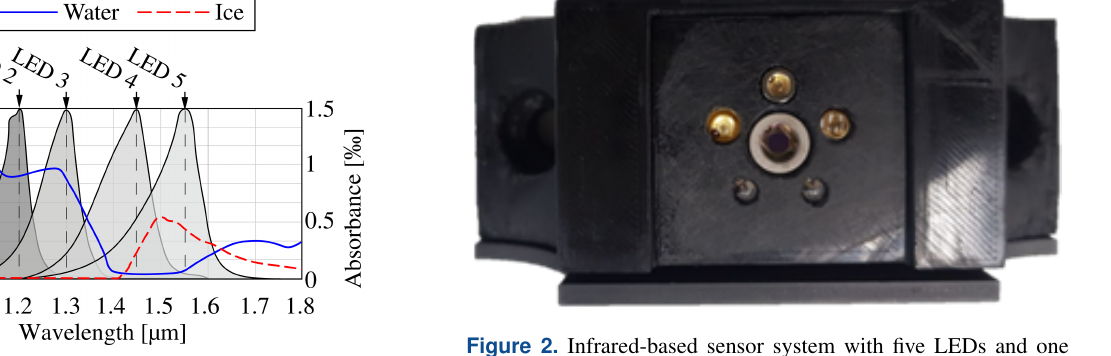
Figure 1. Transmission spectrum of water (blue solid line) (Klem- pau, 2003), the absorption spectrum of ice (red dashed line) (War- ren, 1984) and the spectrum of the selected four LEDs.